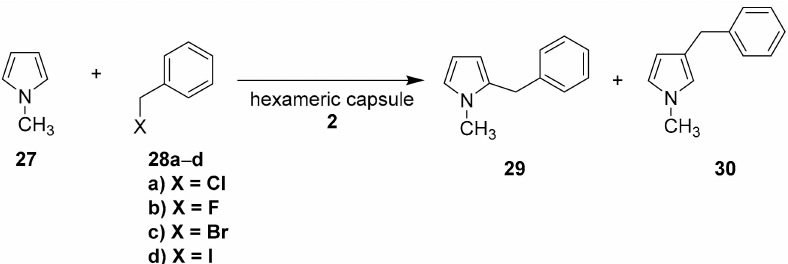
by capsule 2 in water-saturated CDCl 3